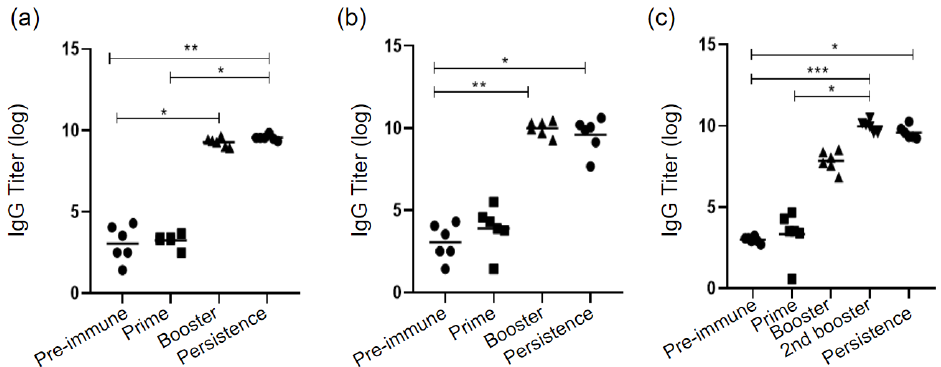
Figure 3. Analysis of IgG titers during the experimental period, by ELISA, in groups ( a ) OMV+AH, ( b ) OMV+DDA and ( c ) OMV+Sap. For statistical analyses, it was used the Friedman test followed by Wilcoxon post-hoc test. * p < 0.05; ** p < 0.01; *** p < 0.001; AH: aluminium hydroxide; DDA: dimethyldioctadecylammonium bromide; OMV: outer membrane vesicles; Sap: Saponin.